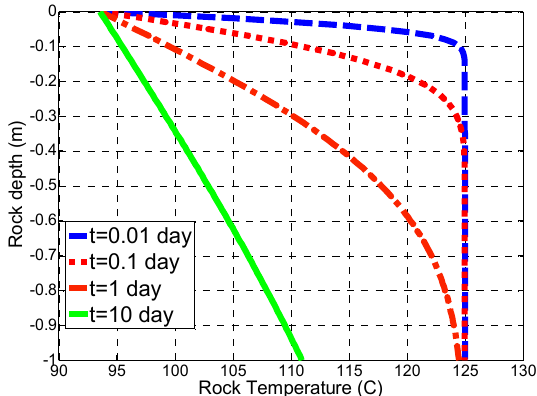
Figure 13. Cooling profile of the rock wall at x = 0.5 m for four different times: 0.01, 0.1, 1, and 10 days. Initial rock temperature is 125 °C. Fracture aperture is 0.005 m. Brine velocity is 0.0368 m/s.